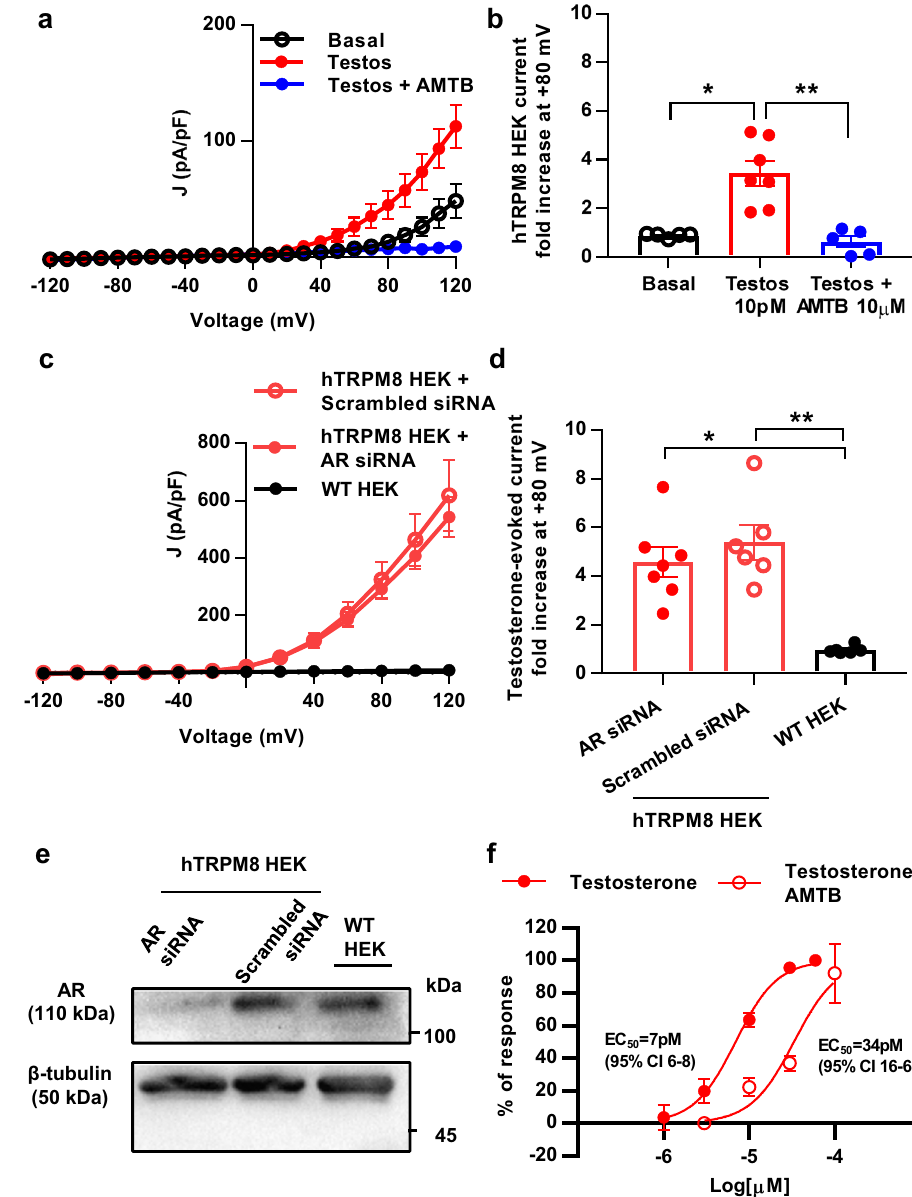
Fig. 5 | Testosterone increases outward current of heterologously expressed human TRPM8, independently of androgen receptor expression. a Current density (pA/pF) vs. voltage relationship evidences increase in outward rectifying current 10pM testosterone in HEK293 cells expressing human TRPM8 (hTRPM8).